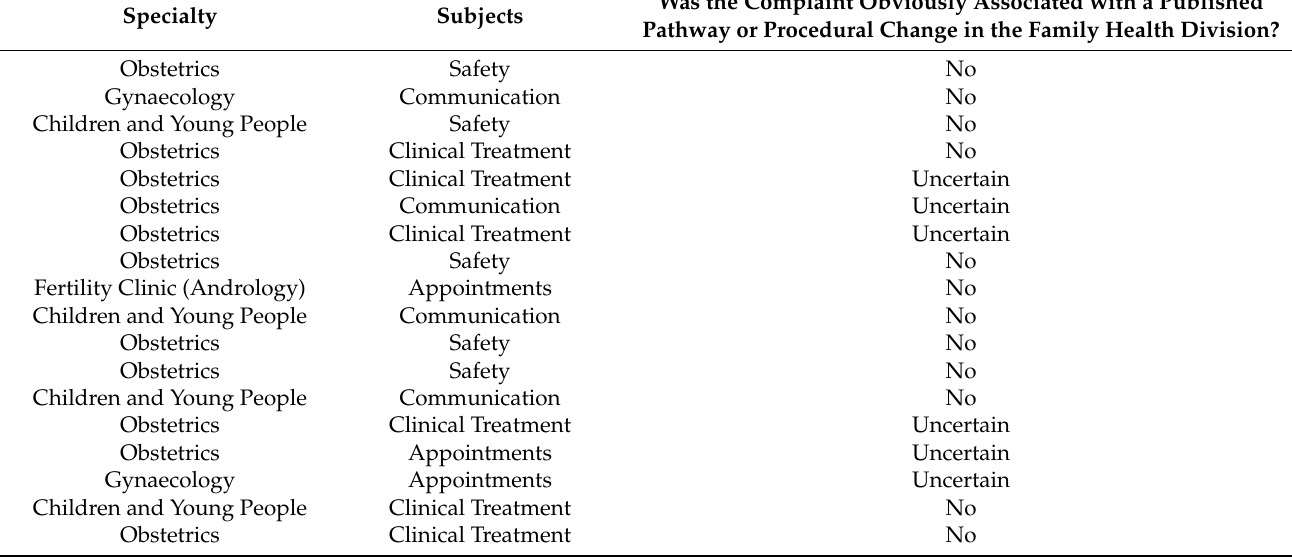
Table 2. Association between complaints and pathway or procedural change in Nottingham University Hospital (NUH) Family Health (FH) division.